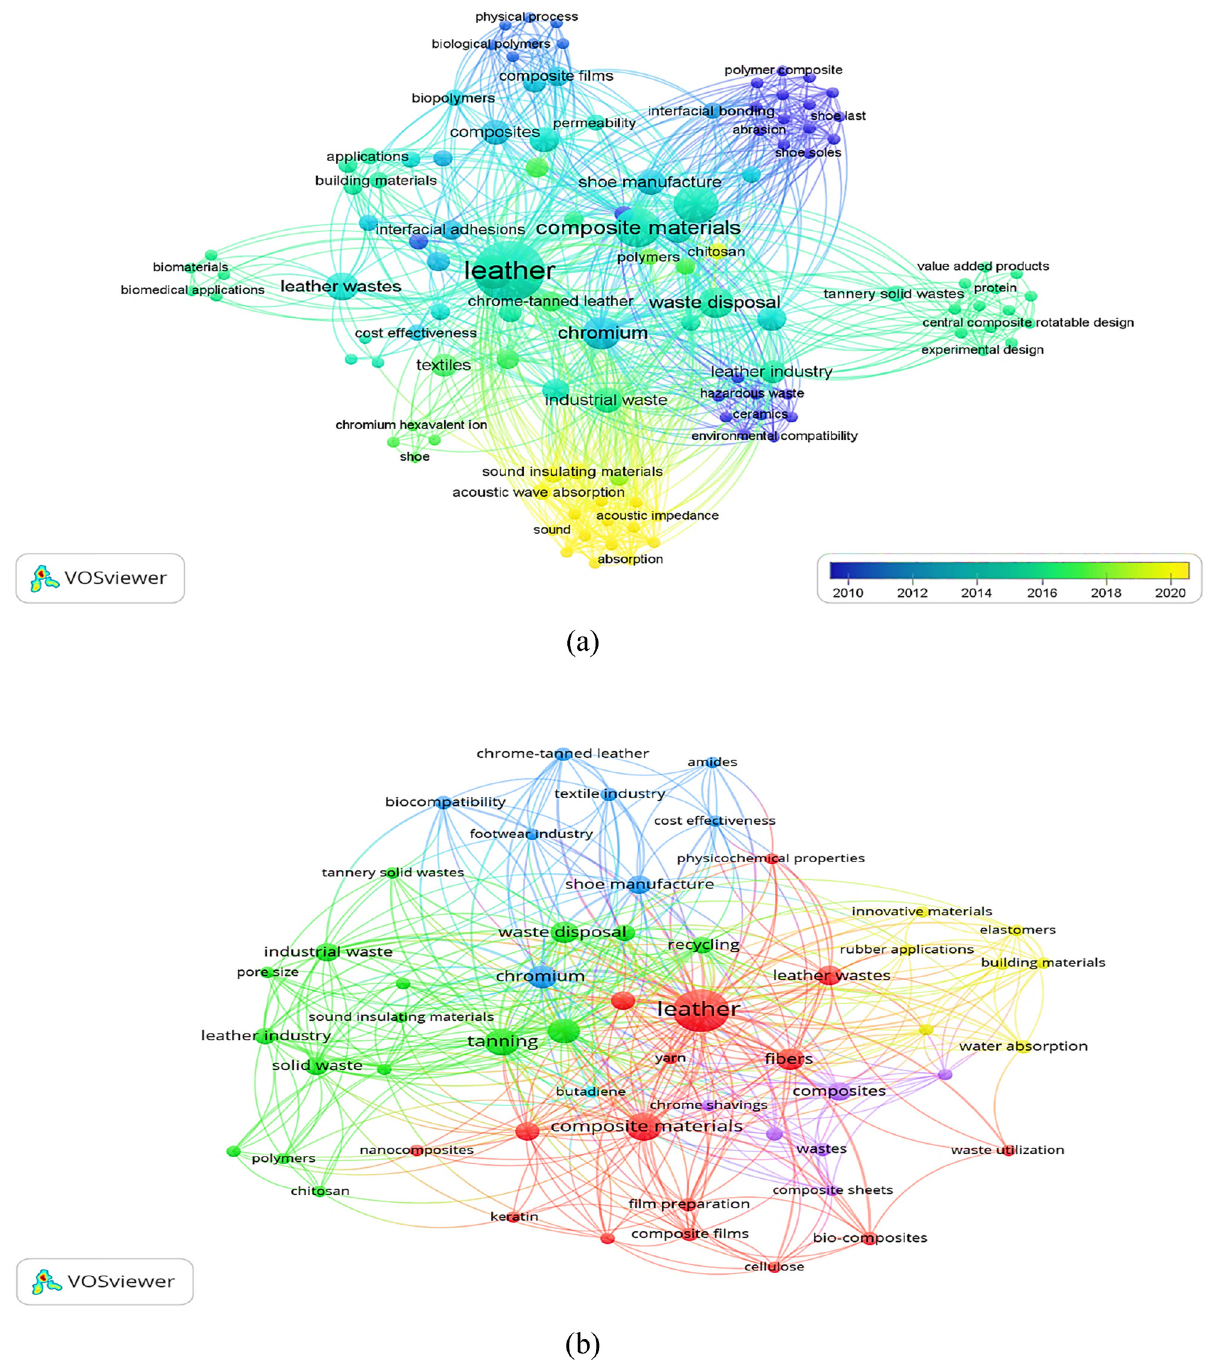
Figure 51: ( a ) Scientometric analysis and ( b ) network analysis exhibiting the comprehensive, diversi fi ed applications of leather bu ffi ng dust reinforced recycled EVA polymer